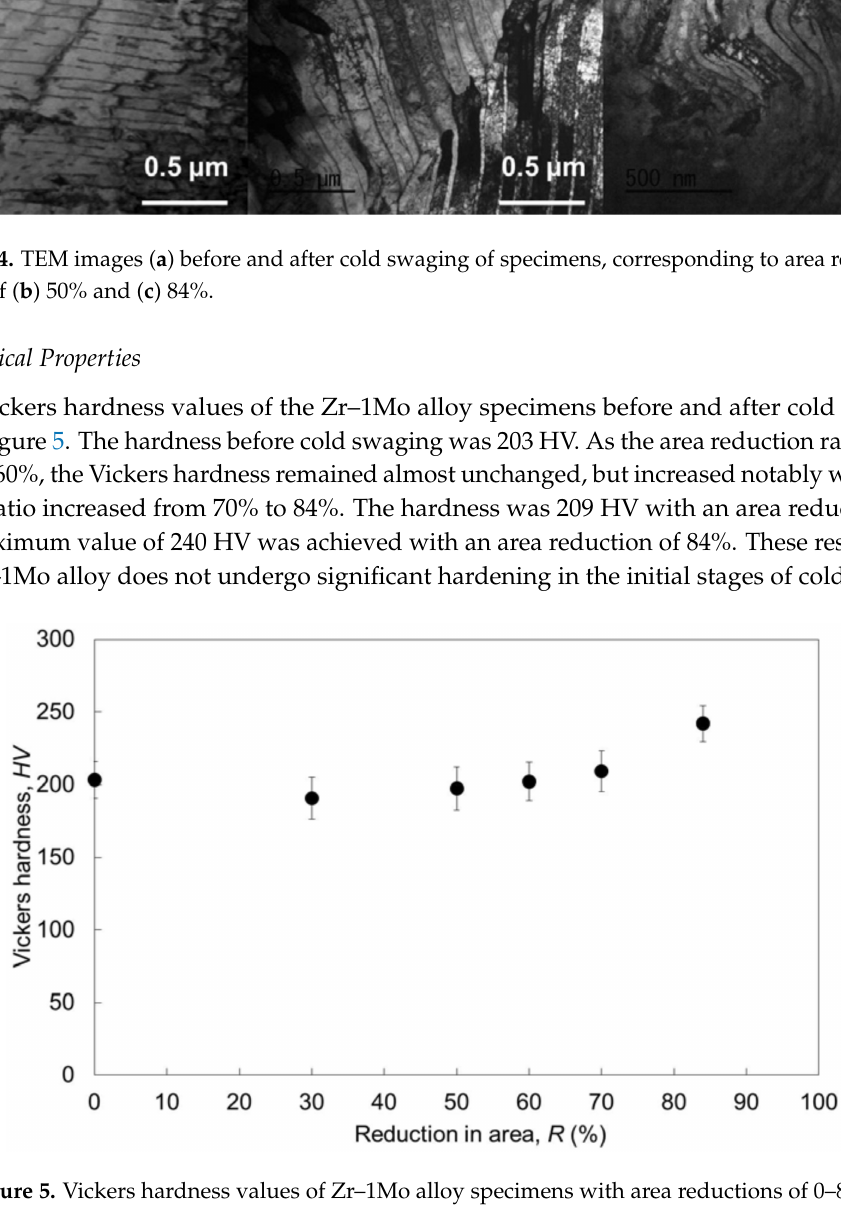
Figure 5. Vickers hardness values of Zr–1Mo alloy specimens with area reductions of